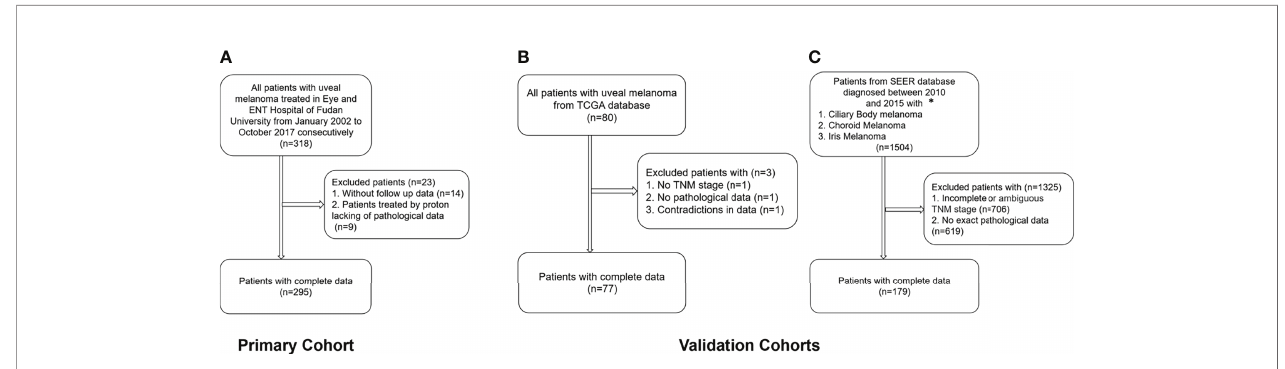
FIGURE 1 | Flow chart of the inclusion and exclusion criteria for the training and validation cohorts. (A) Training cohort; (B) TCGA validation cohort; (C) SEER validation cohort. *Patients with the 7th edition of the TNM classi fi cation were diagnosed between 2010 and 2015 in the SEER